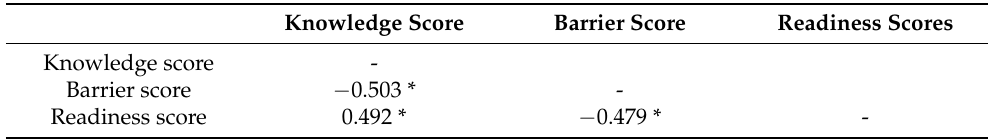
Table 5. Correlations between knowledge, barriers, and readiness scores of street food hawkers in Kelantan to support the single-use plastic reduction program ( n = 440). Knowledge Score Barrier Score Readiness Scores Knowledge score - Barrier score − 0.503 * - Readiness score 0.492 * − 0.479 * - * p -value <